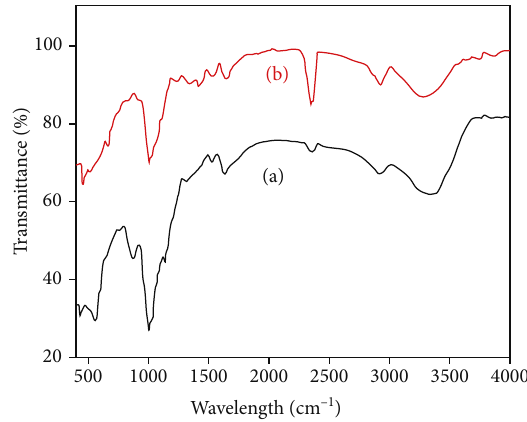
Figure 2: FTIR spectra of CPCN fi lm (a) before and (b) after